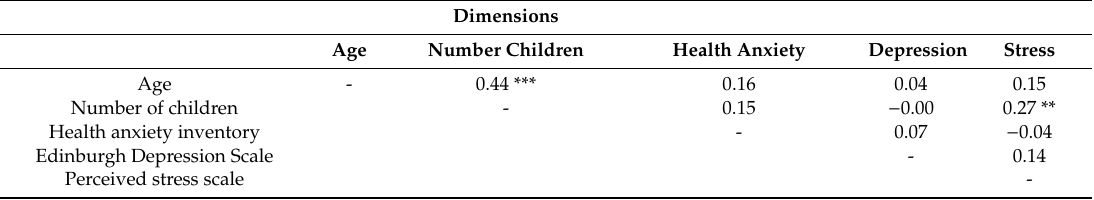
Table 2. Overview of Pearson’s correlation coe ffi cients between age, number of children, health anxiety, depression, and stress.